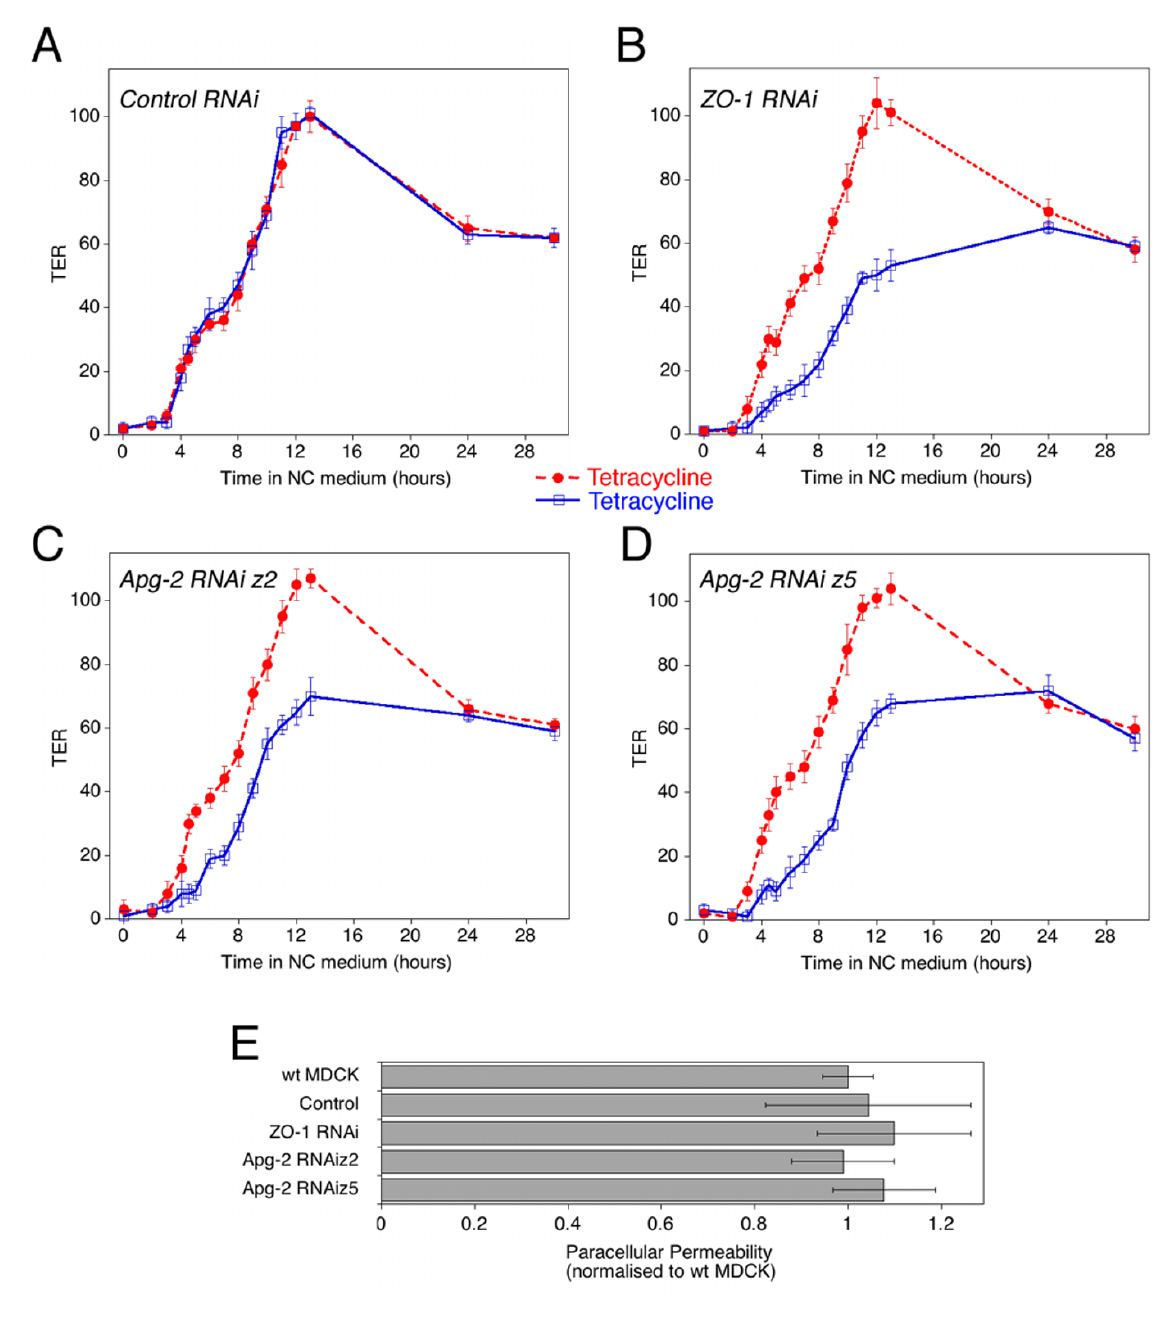
Figure 2 Development of functional tight junctions . (A-D) Cells were plated and incubated without or with tetracycline as described in figure 1. After switching from low calcium to normal calcium medium, TER was measured at the indicated time points. Shown is a typical experiment using a control RNAi cell line (A), a ZO-1 RNAi cell line (B), and two Apg-2 RNAi cell lines (C and D). Values represent means +/- 1 SD of quadruplicates. (E) Paracellular permeability of fluorescent dextran was measured in the same cultures as those shown in panels A to D 3 days after the initiation of junction formation. Shown are the values obtained with 4 kD FITC dextran with tetracycline-treated cultures. Values represent means +/- 1 SD of quadruplicates. Diffusion of 70 kD dextran was also not affected by depletion of Apg-2 and ZO-1 (not